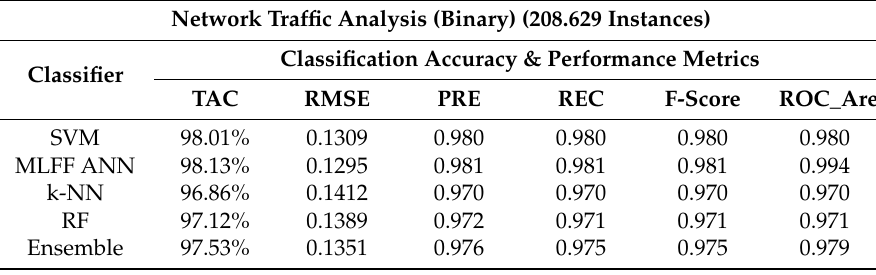
Table 1. Comparison between algorithms.